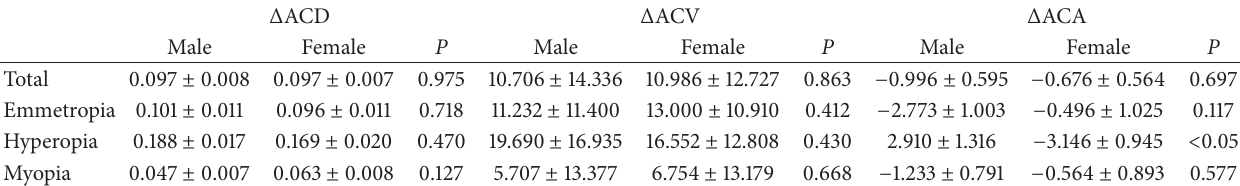
Table 3: Difference in anterior segment parameters between genders among the three groups.